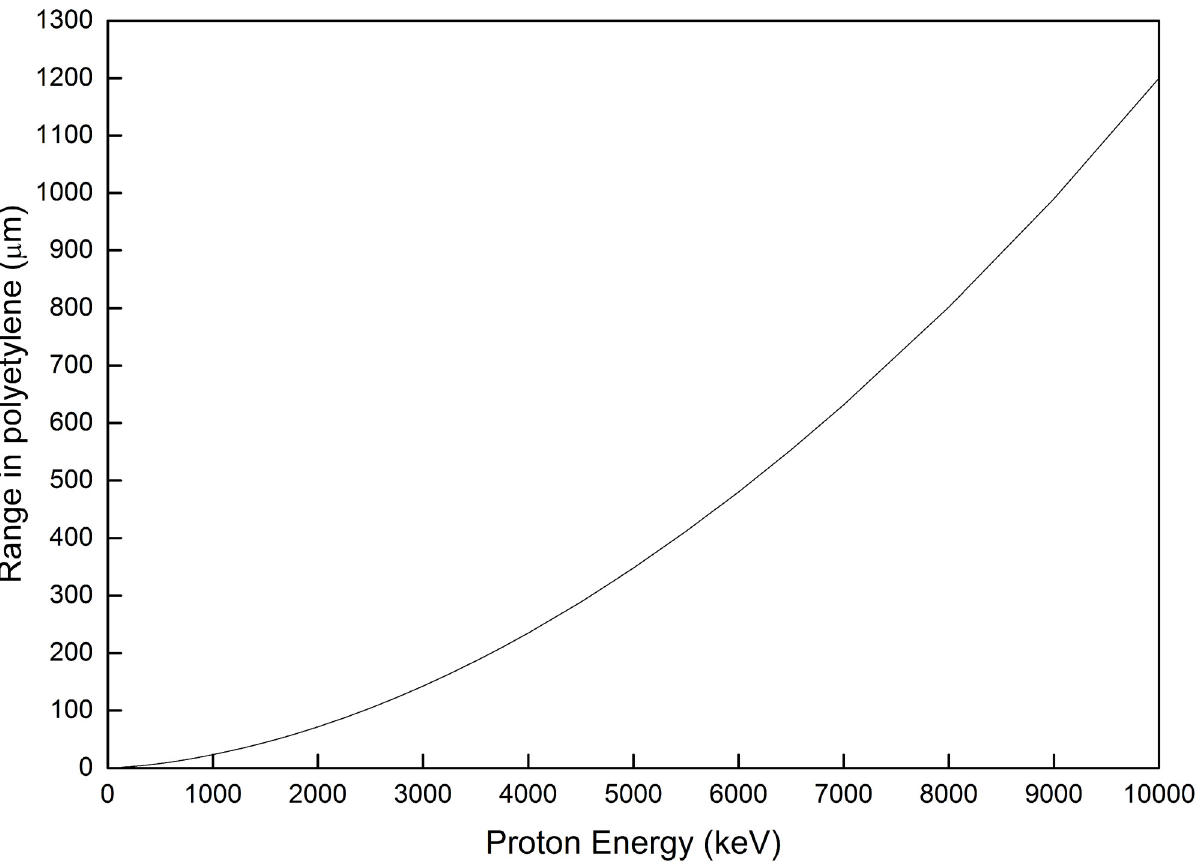
Fig 4. Proton range in PE as a function of the proton energy (obtained using